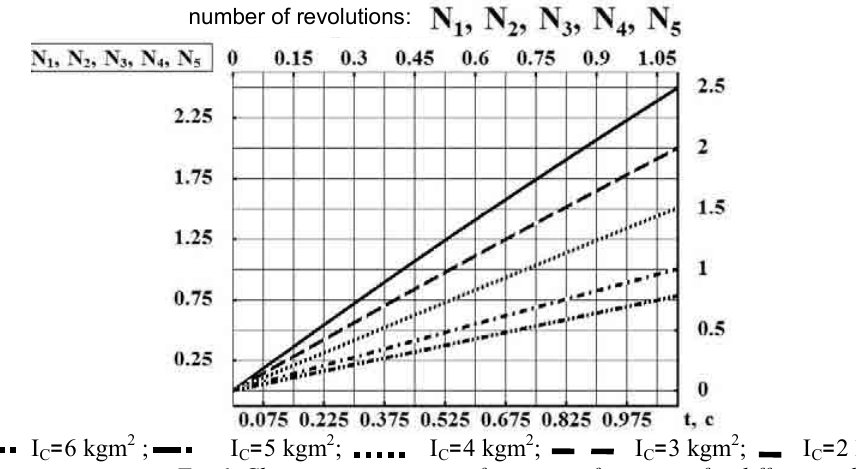
Fig.6. Characteristic curves of quantity of rotations for different values of moments of inertia in respect to front axis